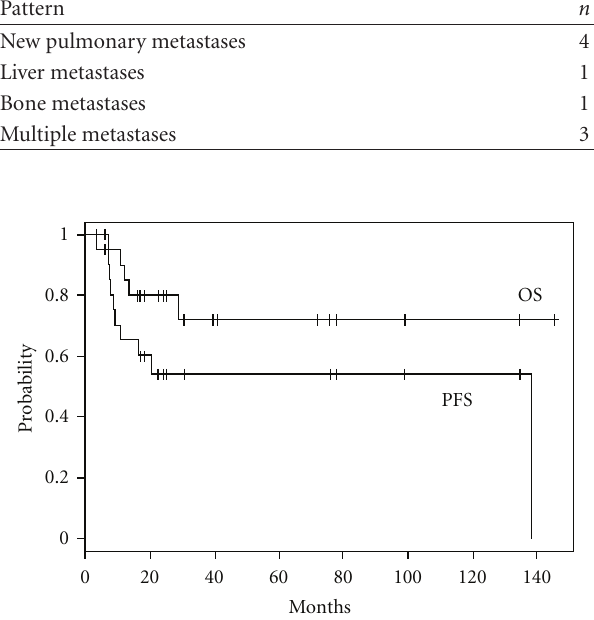
Figure 1: Kaplan-Meier actuarial overall survival (OS) and prog- ression-free survival (PFS) rates.